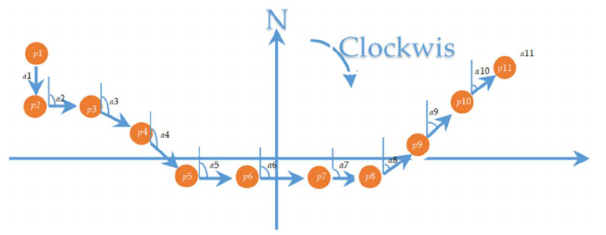
Figure 4. Illustration of the GPS trajectory description based on angle.